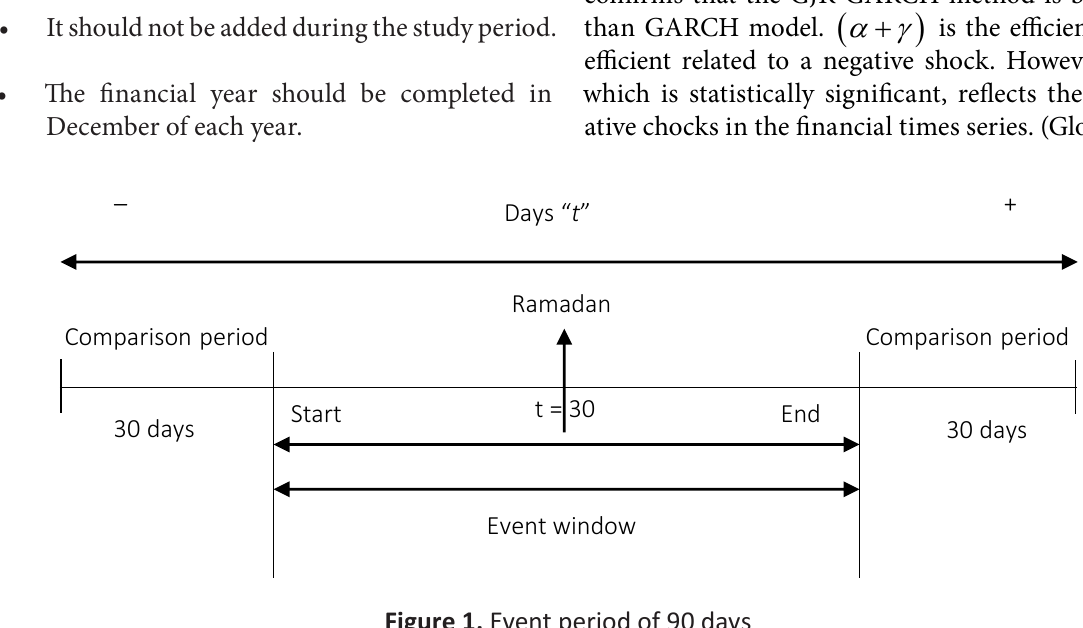
Figure 1. Event period of 90